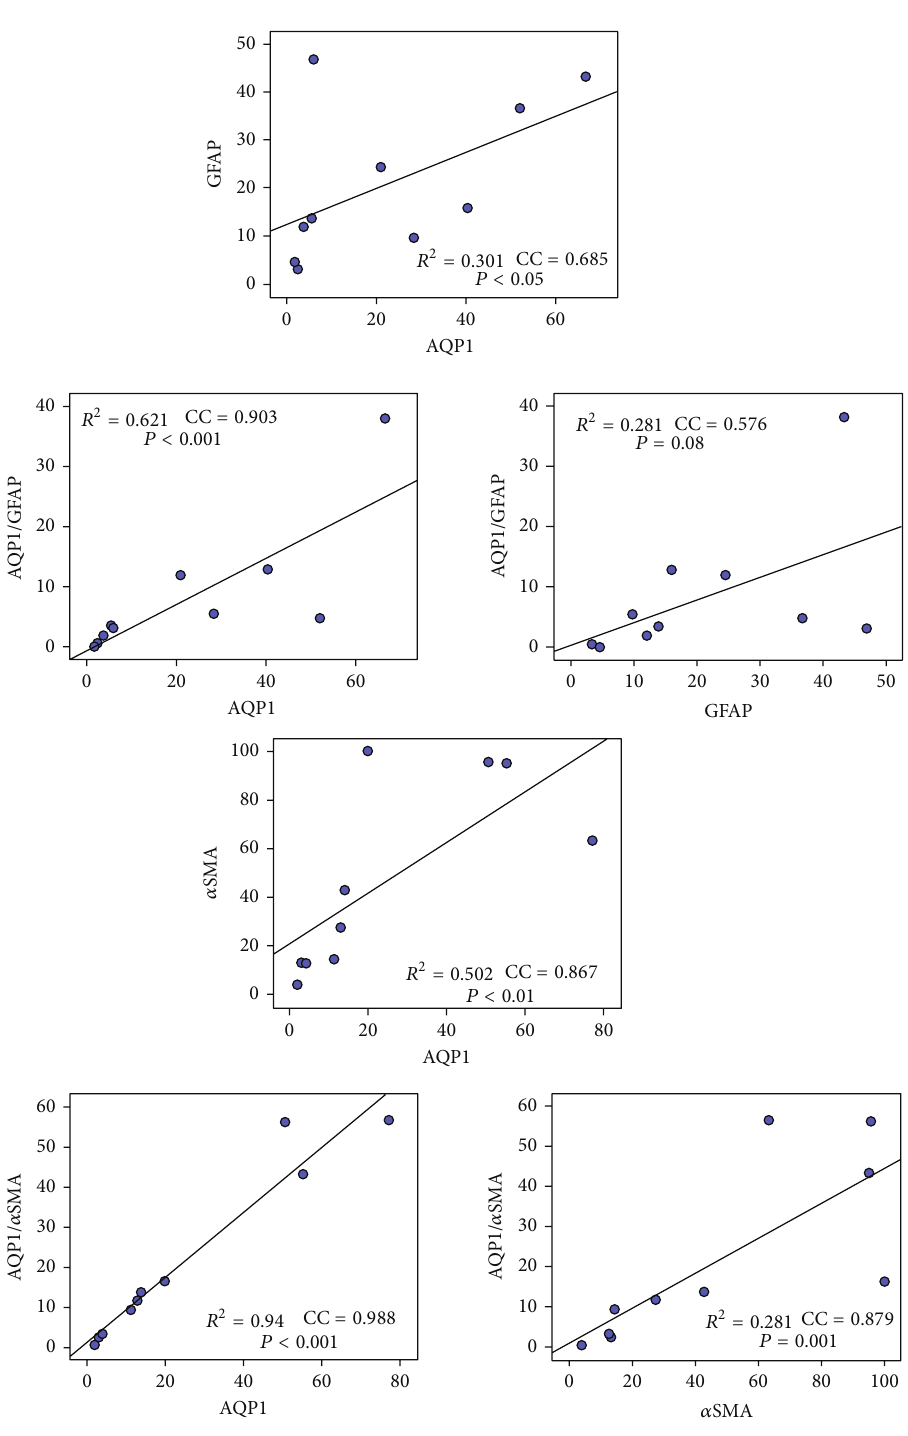
Figure 5: Correlation analysis of cells expressing AQP1, 𝛼 SMA, and GFAP. All the cells labelled with DAPI, AQP1, 𝛼 SMA, and GFAP, with two labels (AQP1/GFAP or AQP1/ 𝛼 SMA), were counted and expressed as mean ± S.E.M. (𝑛 = 10) . All the combinations between the variables explored are shown in each graph, where dots represent the mean numbers of cells labelled in each membrane for the investigated variable. Straight lines on each graph represent the best fit linear regression and do not reflect Spearman rank correlation. 𝑅 2 indicates the coefficient of determination, CC is the Spearman correlation coefficient, and 𝑃 is the statistical level of significance. Spearman correlation tests were performed using IBM-SPSS statistical